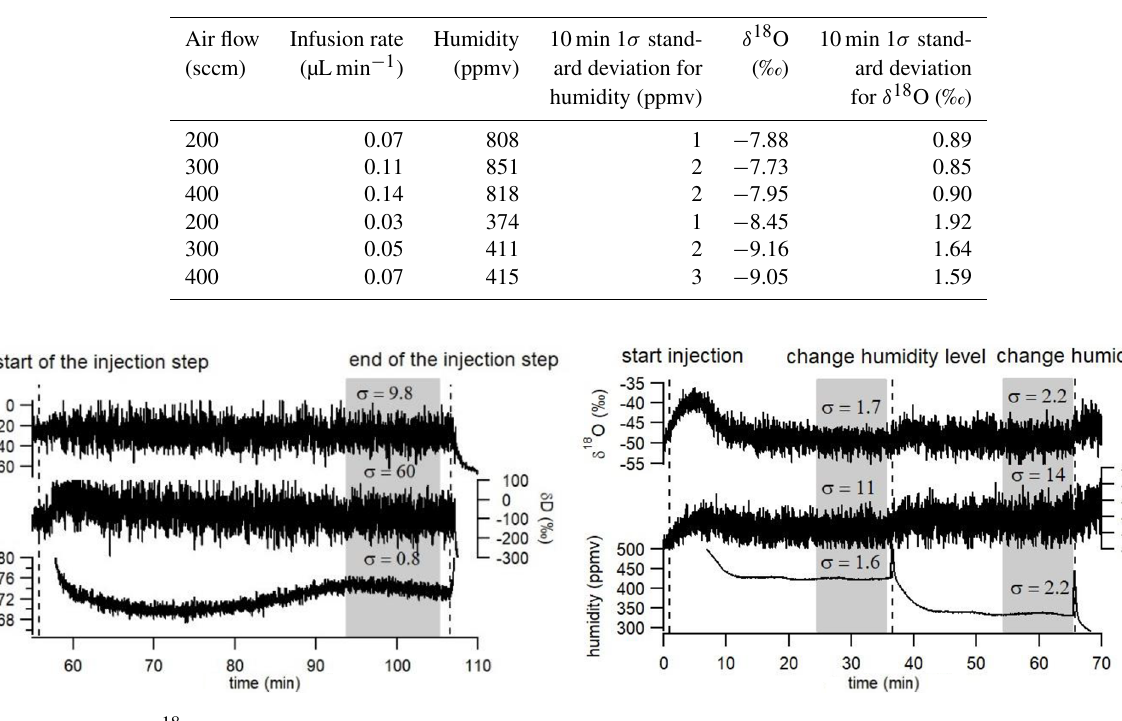
Figure 4. Records of δ 18 O, δ D and humidity over three humidity plateaus (72ppmv on the left, 425 and 335ppmv on the right) obtained with the LHLG. The gray rectangles indicate the period (10min) over which the average values are kept for calibrating the data generated by the L2130-i analyzer.